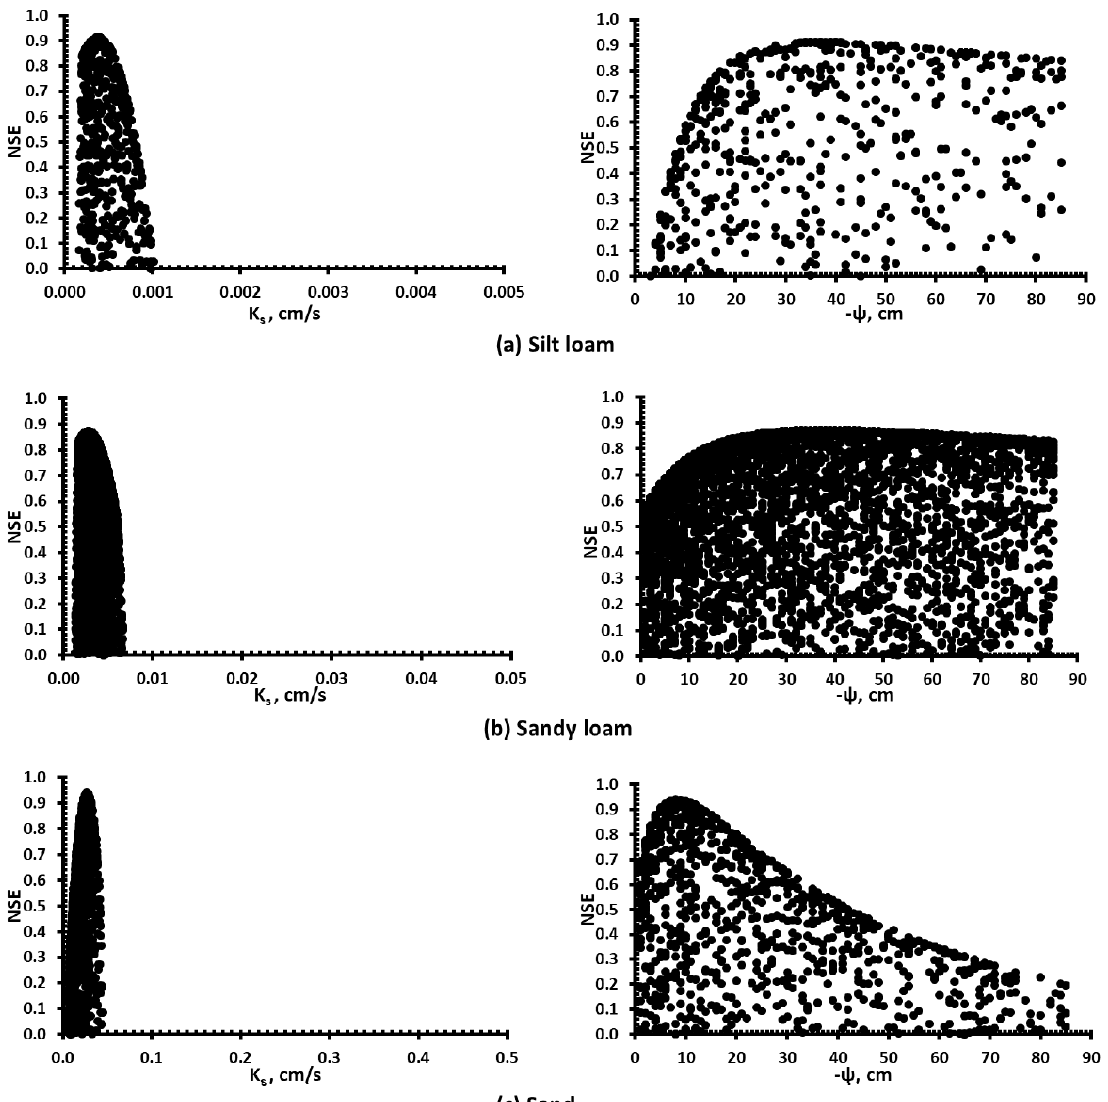
(cid:16) (cid:17) t j Figure 7. Scatter plots for the NSE calculated between ∆ H s determined by Equation (5) and the Figure 7. Scatter plots for the NSE calculated between ∆(cid:1834) (cid:3046) ((cid:1872) (cid:3037) ) determined by Equation 5 and the (cid:16) (cid:17) changes in measured head ∆ H t j , on the left is K s versus NSE and − Ψ versus NSE is on the right. ( a ) changes in measured head ∆H(t (cid:2920) ) , on the left is Κ s versus NSE and – Ψ versus NSE is on the right. ( a ) Silt loam, ( b ) Sandy loam, and ( c ) Silt loam, ( b ) Sandy loam, and ( c ) Sand.